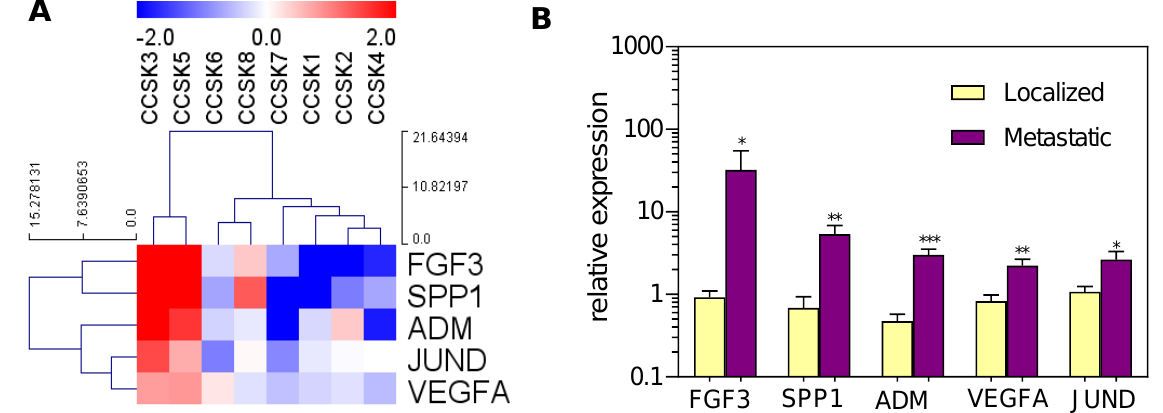
Figure 2. ( A ) Heatmap representation of selected differentially expressed genes between metastatic (CCSK3 and CCSK5) and localized samples as measured by WTS. ( B ) Validation of differentially expressed genes by quantitative PCR (*, p < 0.05; **, p < 0.01; ***, p < 0.001).